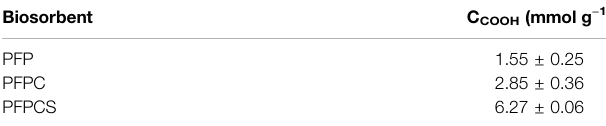
TABLE 1 | Degree of succinylation of the